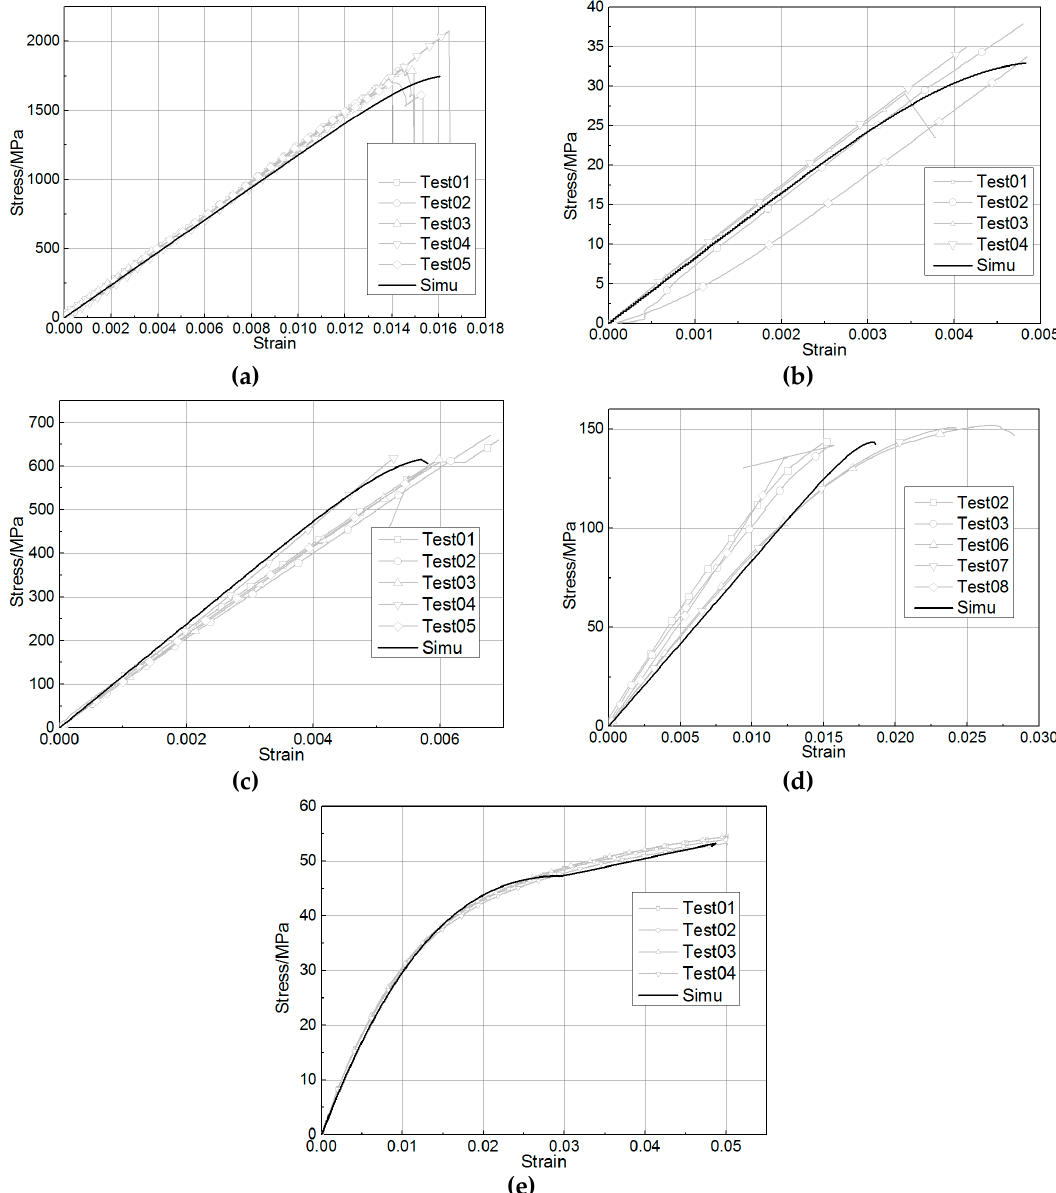
Figure 5. Comparison between test and simulation at the coupon level. ( a ) 0° tension. ( b ) 90° tension. ( c ) 0° compression. ( d ) 90° compression. ( e ) Shear.